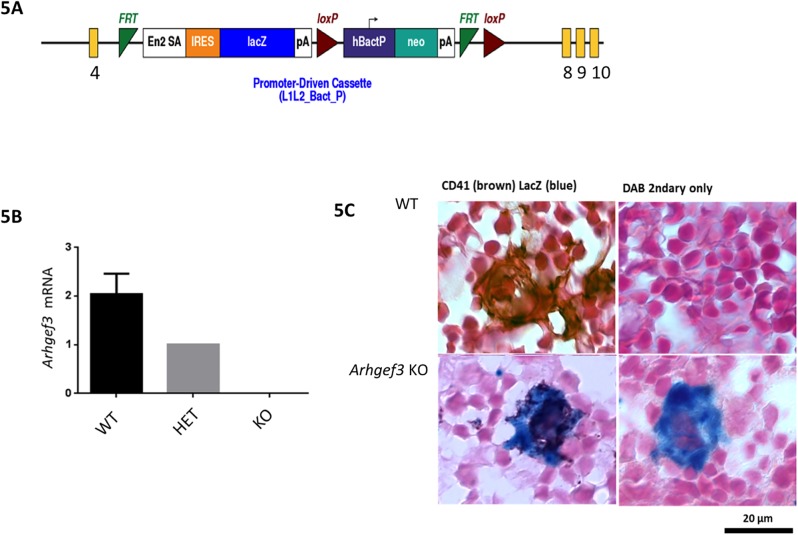
ARHGEF3 knockout design and confirmation of Arhgef3 knockout in the megakaryocyte lineage.(A) Arhgef3 KO design from KOMP: The wild type Arhgef3 gene is disrupted by replacement of exons 5–7 with a gene cassette containing a splice acceptor (En2SA), an IRES and LacZ cDNA. The neomycin resistance gene has its own beta actin promoter. (B) Arhgef3 KO confirmation: qRT-PCR for Arhgef3 in fresh bone marrow cells from WT, ARHGEF3 heterozygous and homozygous KO mice confirmed the complete loss of ARHGEF3 in the KO mice. (C) LacZ/β-galactosidase staining on E13 mouse liver from wild type (WT) or Arhgef3 homozygous knockout embryos shows that Arhgef3 KO MKs are positive for both CD41 (brown) and LacZ/β-galactosidase staining (blue).